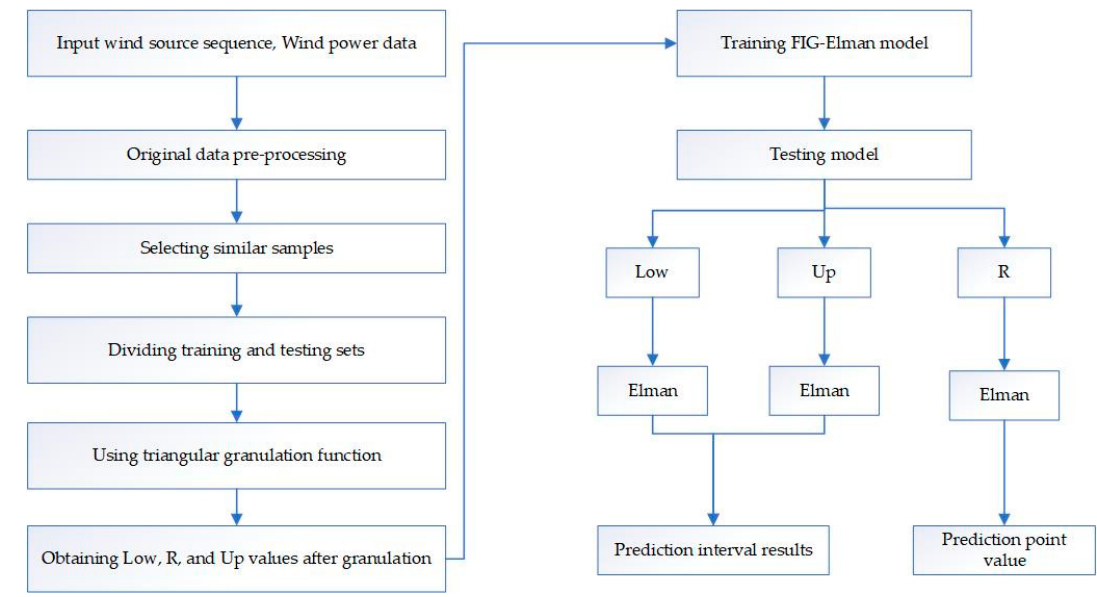
Figure 5. Flow chart of wind power prediction interval model based on FIG-Elman method.